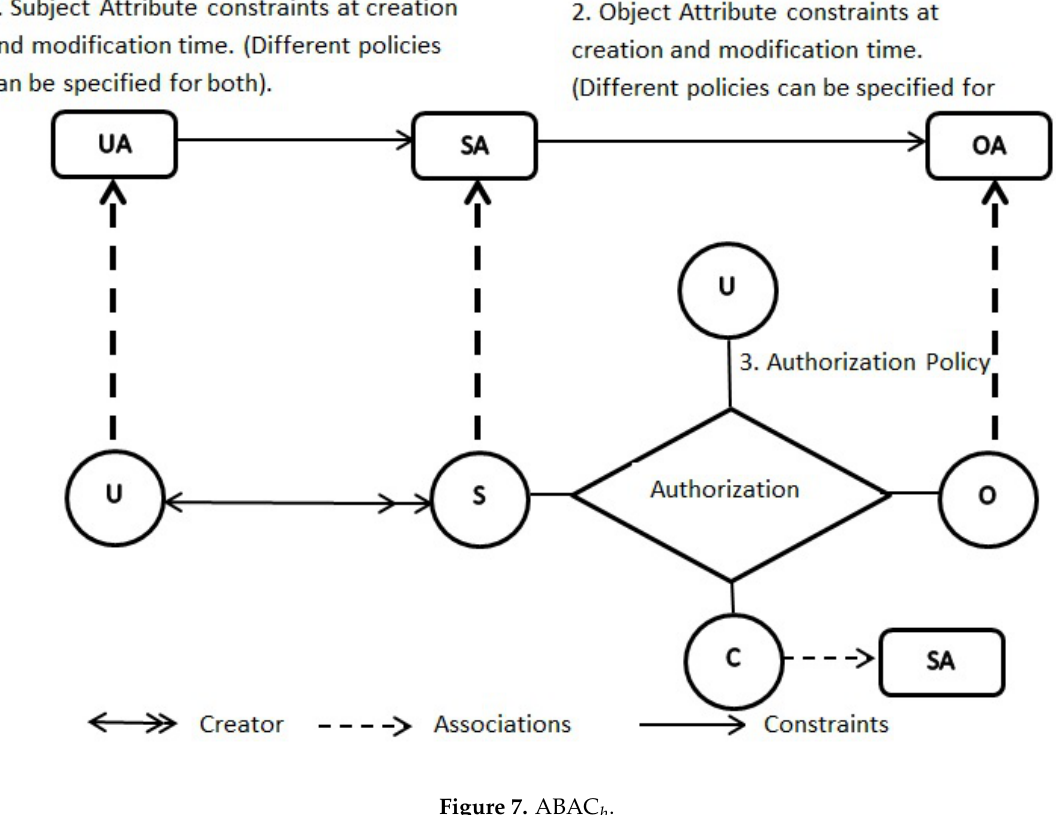
Figure 7. ABAC b